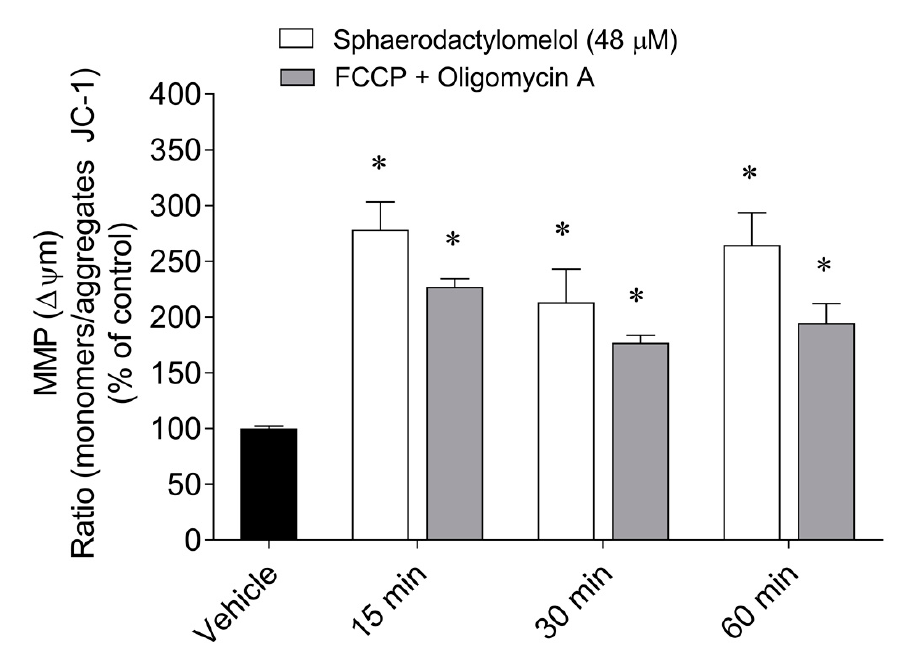
Figure 3. Mitochondrial membrane potential (MMP) of MCF-7 cells after treatment with sphaero- dactylomelol (48 µM) and FCCP (2.5 µM) plus oligomycin A (1 µg/mL) for 15, 30, and 60 min. The results were expressed as the ratio between the monomers/aggregates of JC-1. Values represent the mean ± SEM of three or four independent experiments. Symbols represent significant differ- ences ( p < 0.05) when compared to: * control.